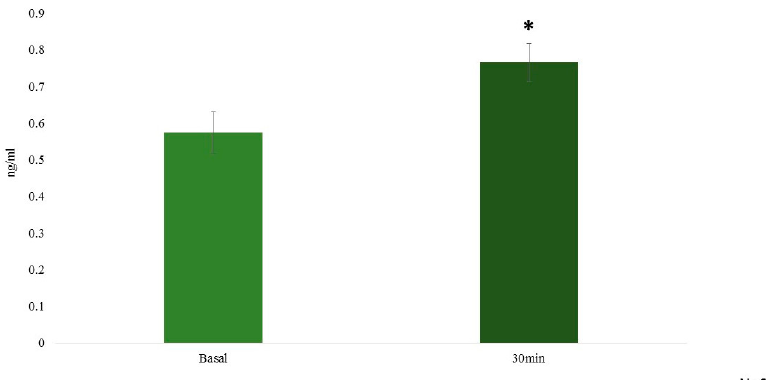
Figure 3. Graphical representation showing statistically significant increase in the levels of VIP ( p value = 0.006735) upon i.p. injection of GA 10 mg/kg/bw at time zero (Basal) and after 30 min of GA stimulation (N = 6). * p < 0.01.